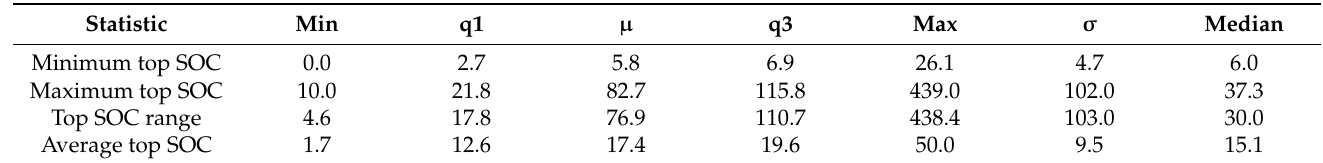
Table 1. Basics stats of topsoil SOC content values (top SOC, g · kg − 1 ) across 46 study areas with full description of measured sampled sets [18,26,31,34–36,41,44,47–50,52,54,55,57,58,61,64,67,72–82],